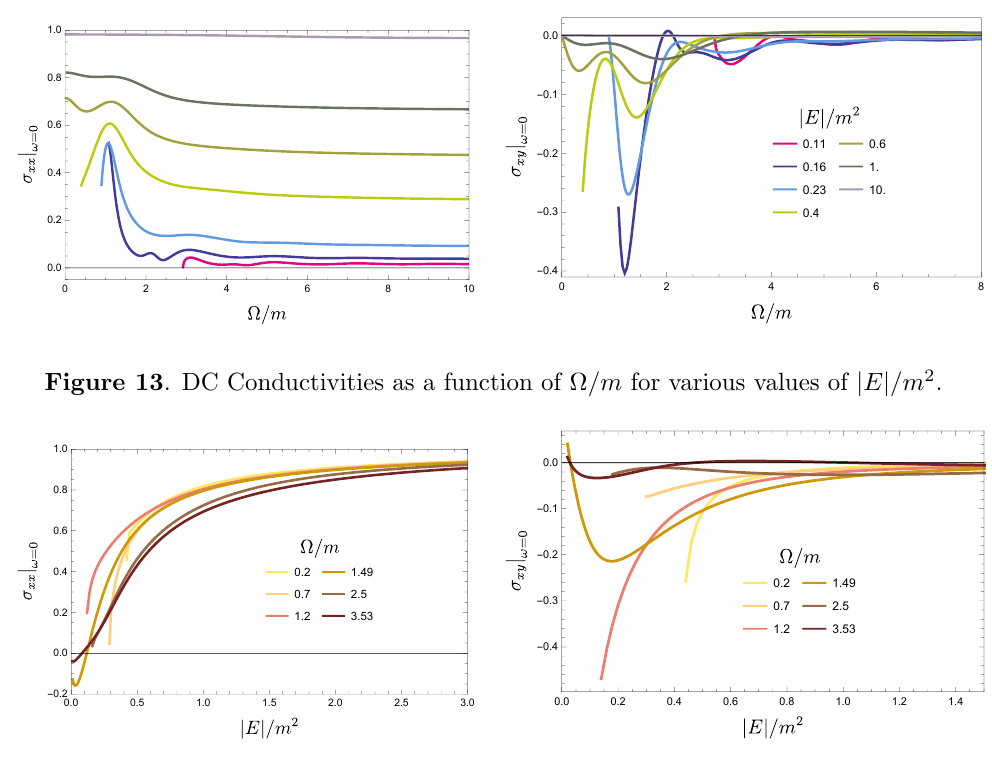
Figure 14 . DC Conductivities as a function of j E j =m 2 for various values of (cid:10) =m . obtained in [50] where it becomes a constant that only depends on m , and saturates to a maximum value equal to one (see section 6.3 below for the correct